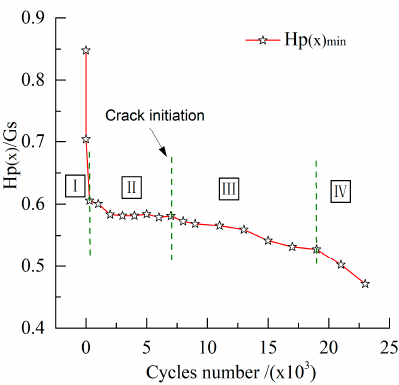
Figure 14. Variations of H p (x) min at different fatigue cycles.